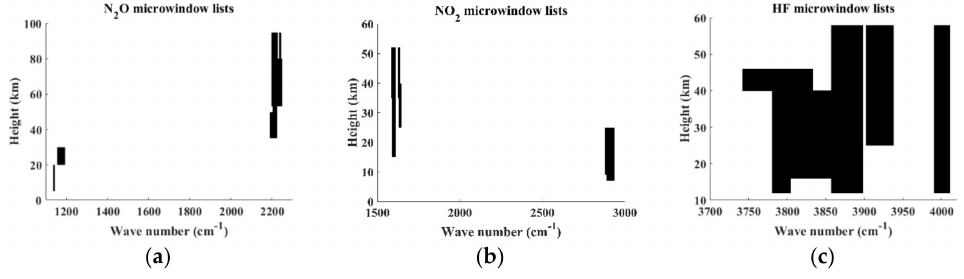
Figure 2. Microwindow lists. ( a ) For N 2 O; ( b ) for NO 2 ; ( c ) for